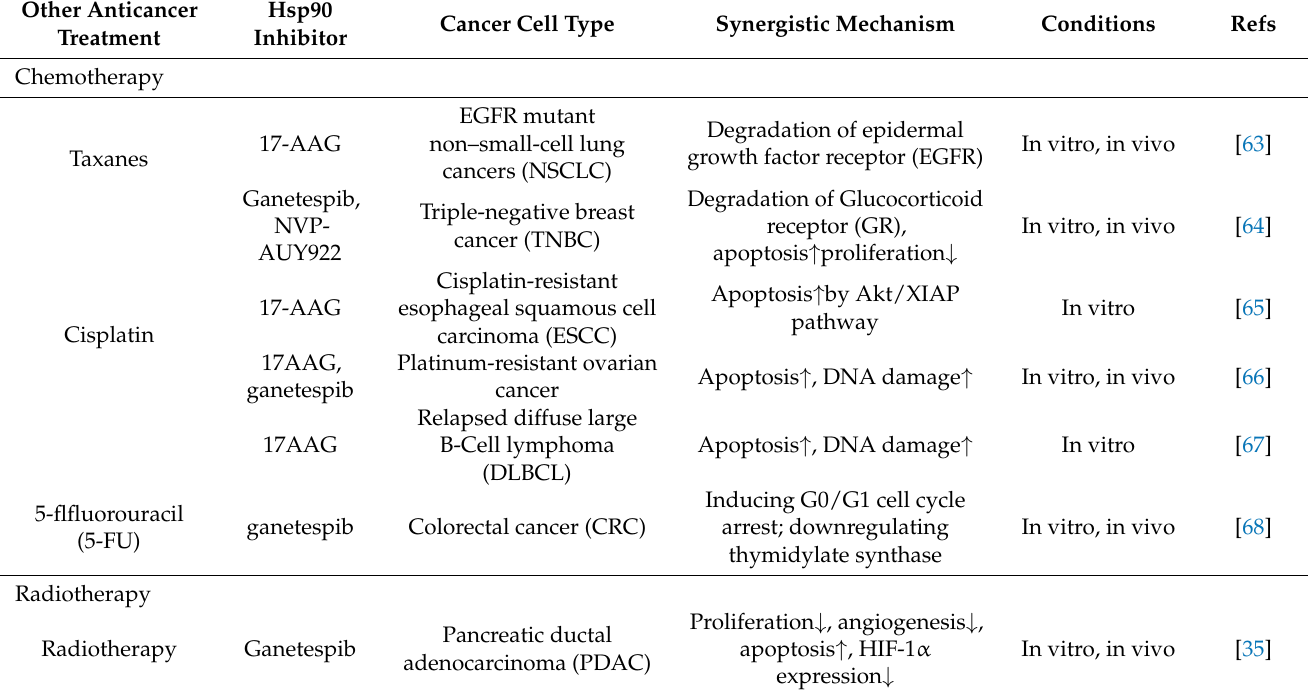
Table 2. HSP90 inhibitors synergizing with other anticancer